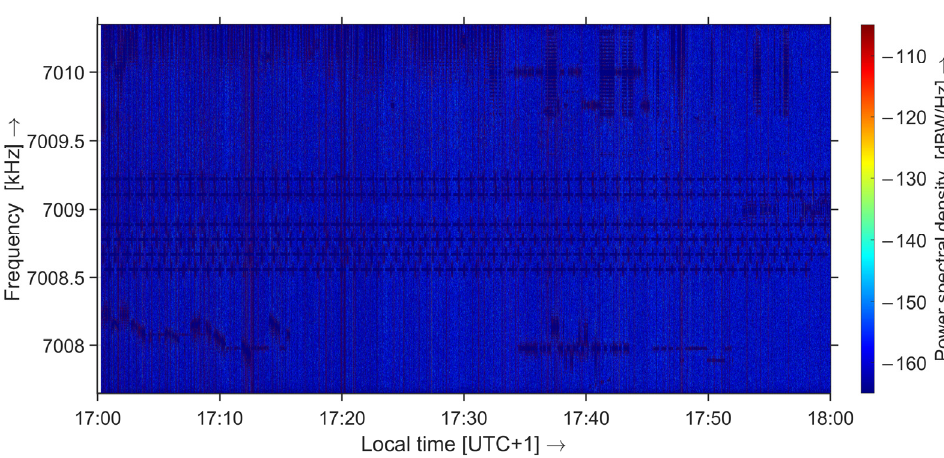
Figure 11. Spectrogram of the same 1-h time fragment of measurements as in Figure 9, but after removal of wideband impulsive noise. Only the background ambient noise remains.